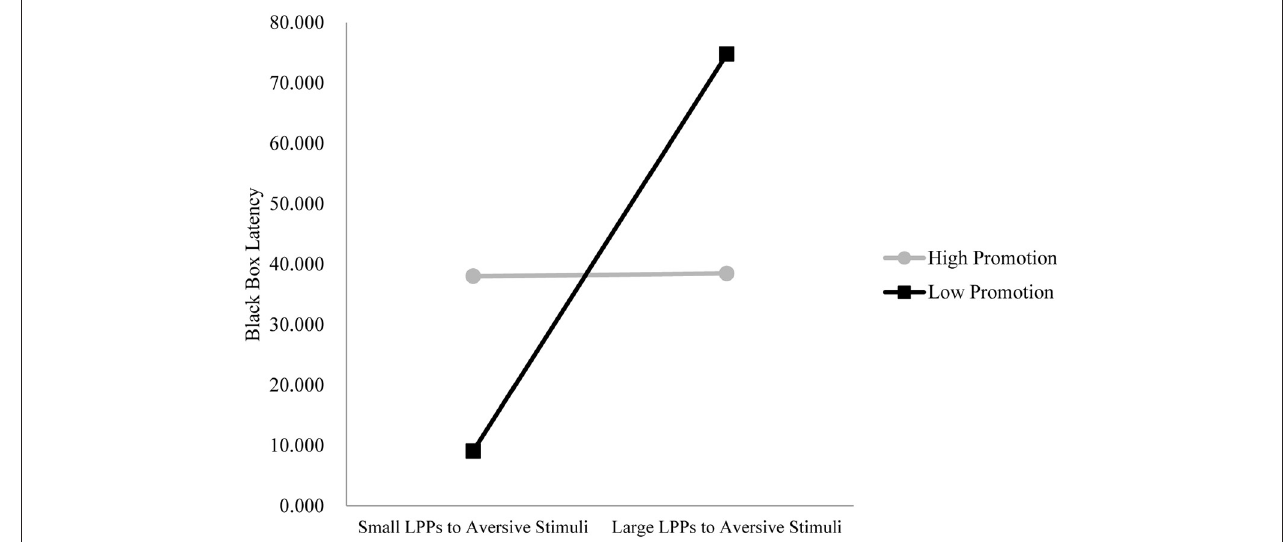
images in the anterior region/late window. Model with LPP (anterior/late), Promotion Parenting, LPP × Promotion: (cid:2) R 2 = 0 . 186; unstandardized